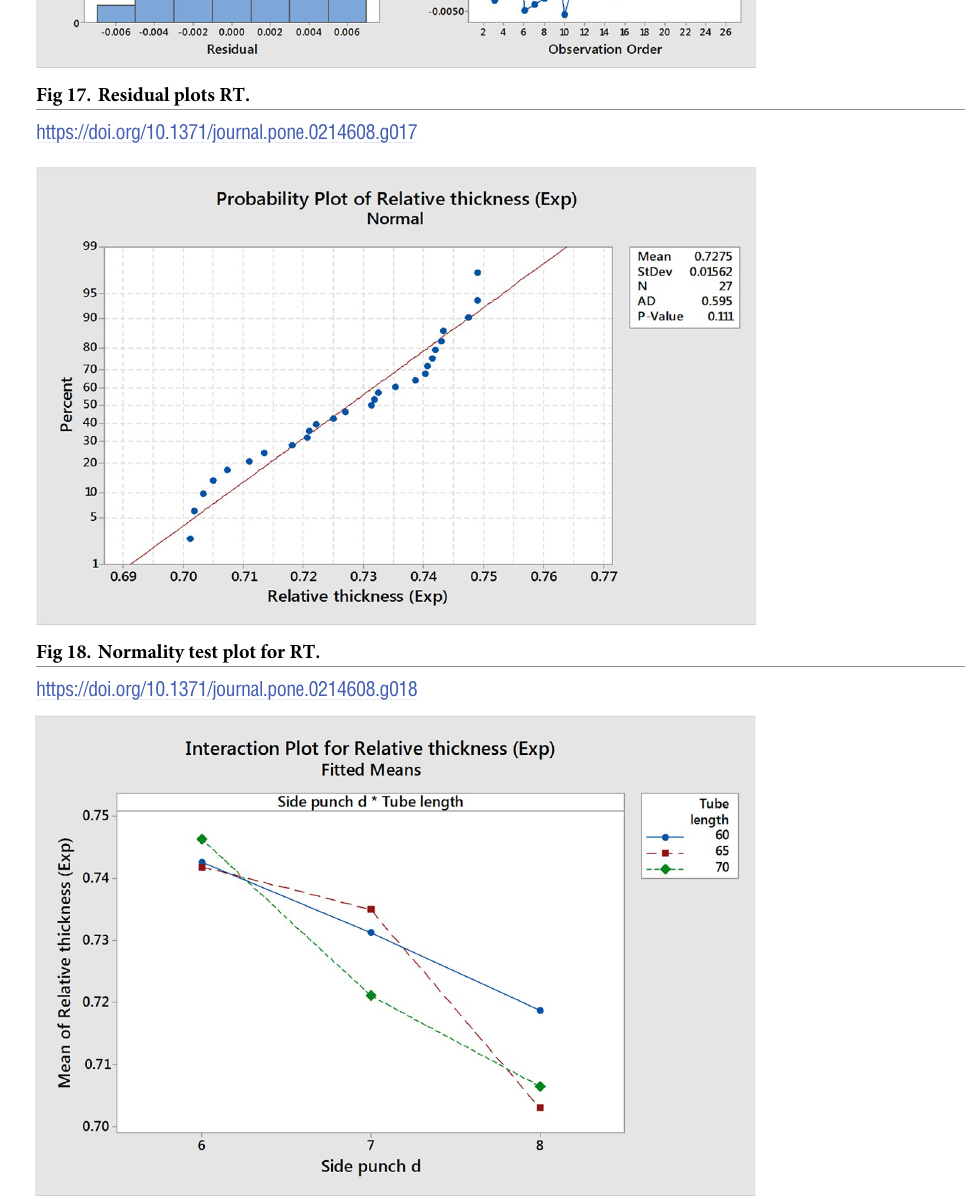
Fig 19. Interaction plot for